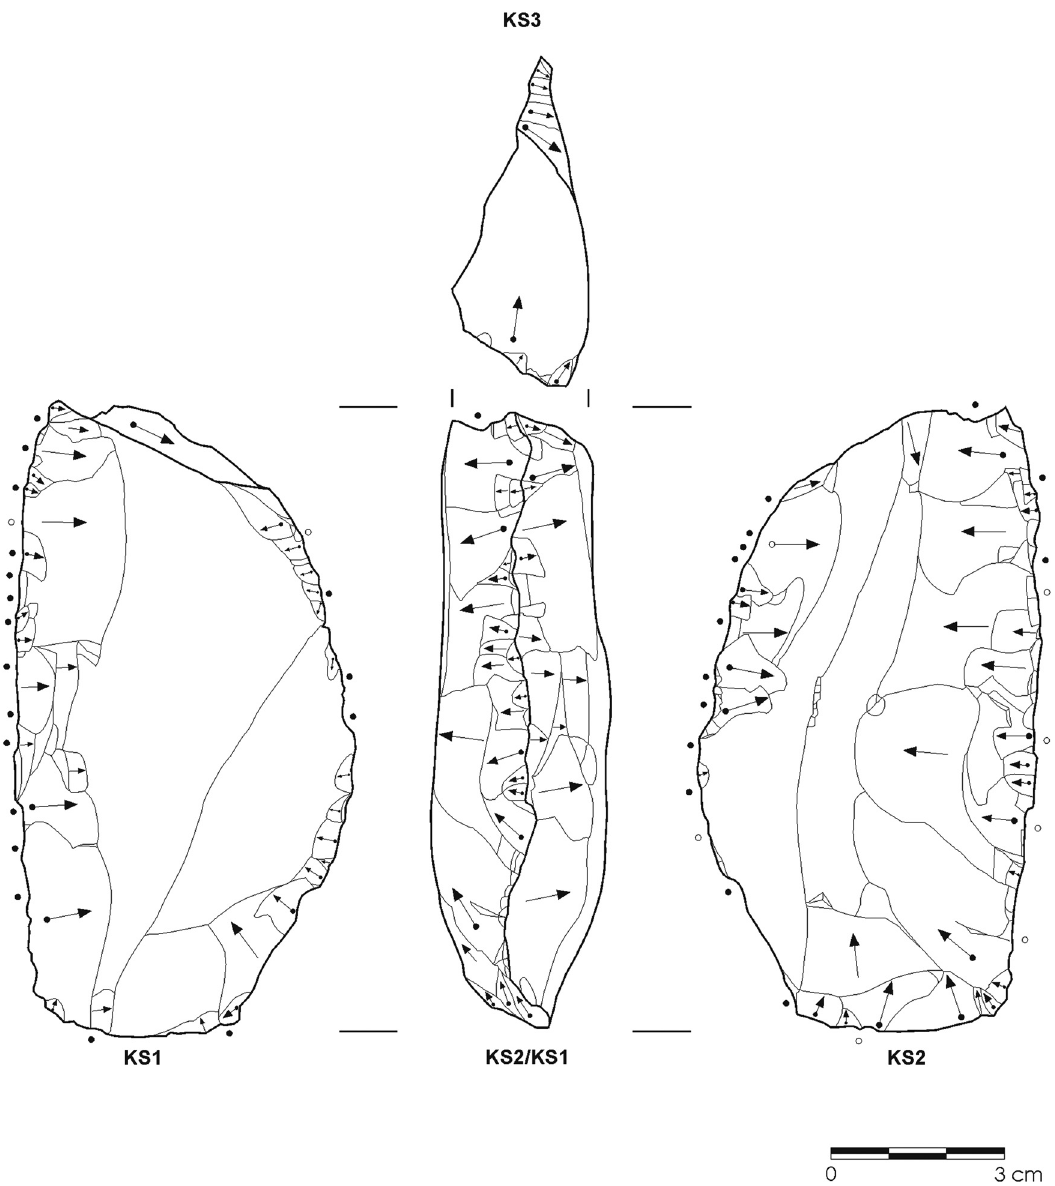
Figure 3: Opaline fl int core interpreted as pedagogical demonstration due to a complex and well - executed con fi guration. Number: 1327/55. KS: knapping surfaces. Drawing: Paco Fernández © Casa Montero Project ( Castañeda, 2018, p. 738, Figure 8 )